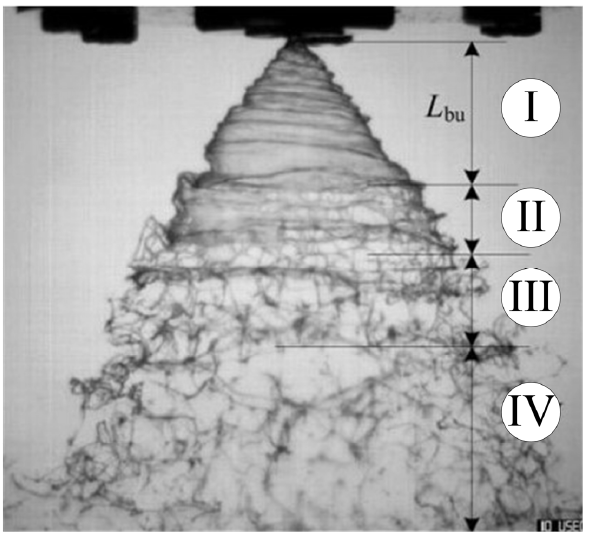
Figure 13. Typical regions of flow destruction along the breakup length [172].